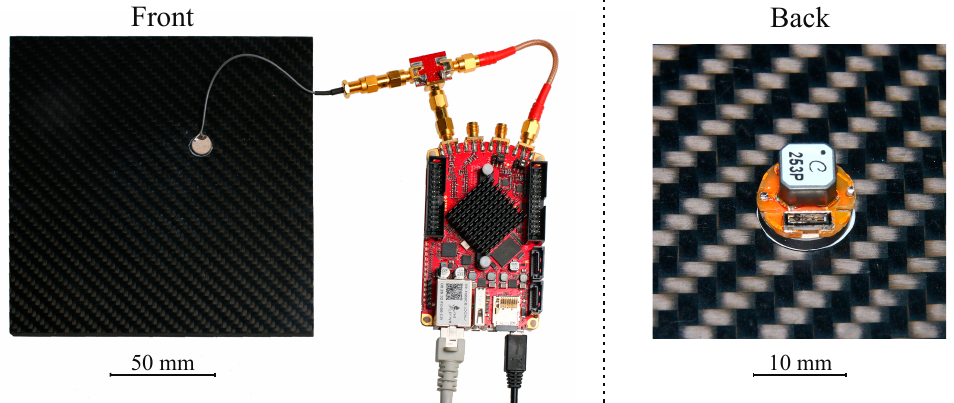
Figure 4. Demonstration measurement setup with outer piezoelectric disc transducer T R and the readout unit ( left ) and the inner passive sensor node with piezoelectric transducer T S coaxially coupled to T R through a 10 mm thick CFRP plate with the high-Q resonator and impedance matching mounted on a printed circuit board ( right ).